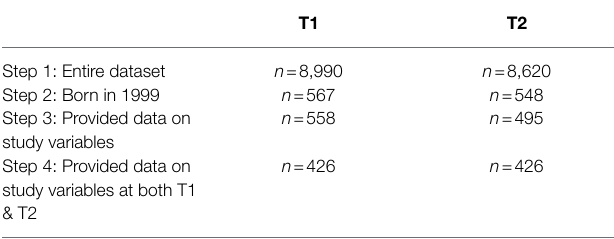
TABLE 1 | Data filtering